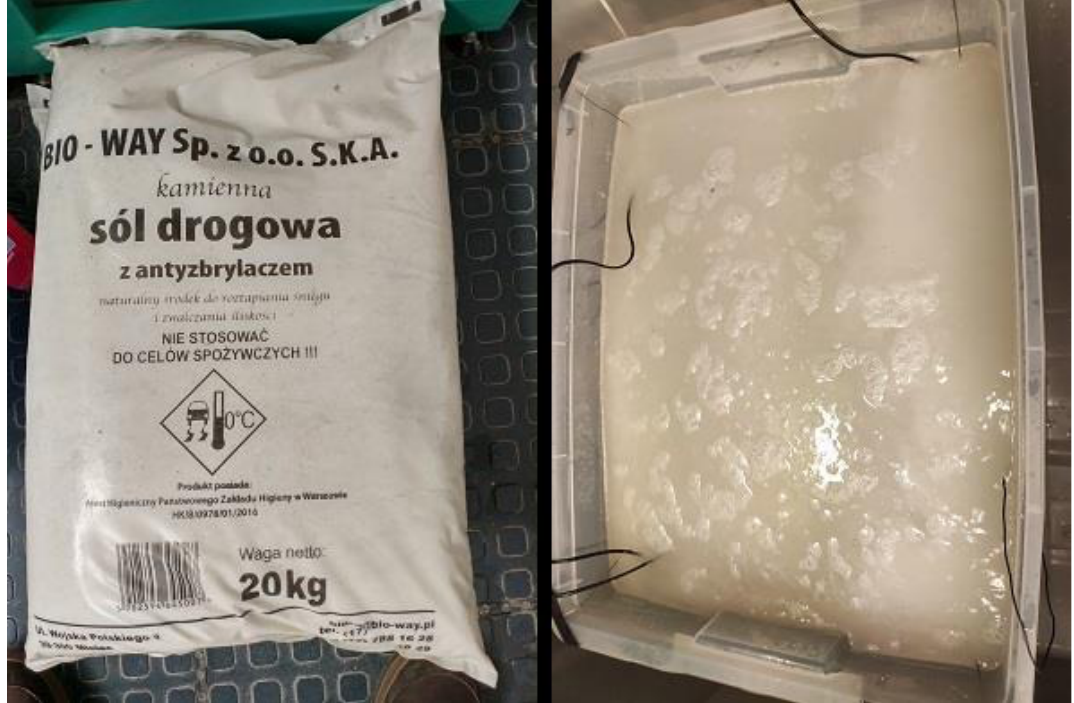
Figure 5. Road salt used in the experiment and brine solution.